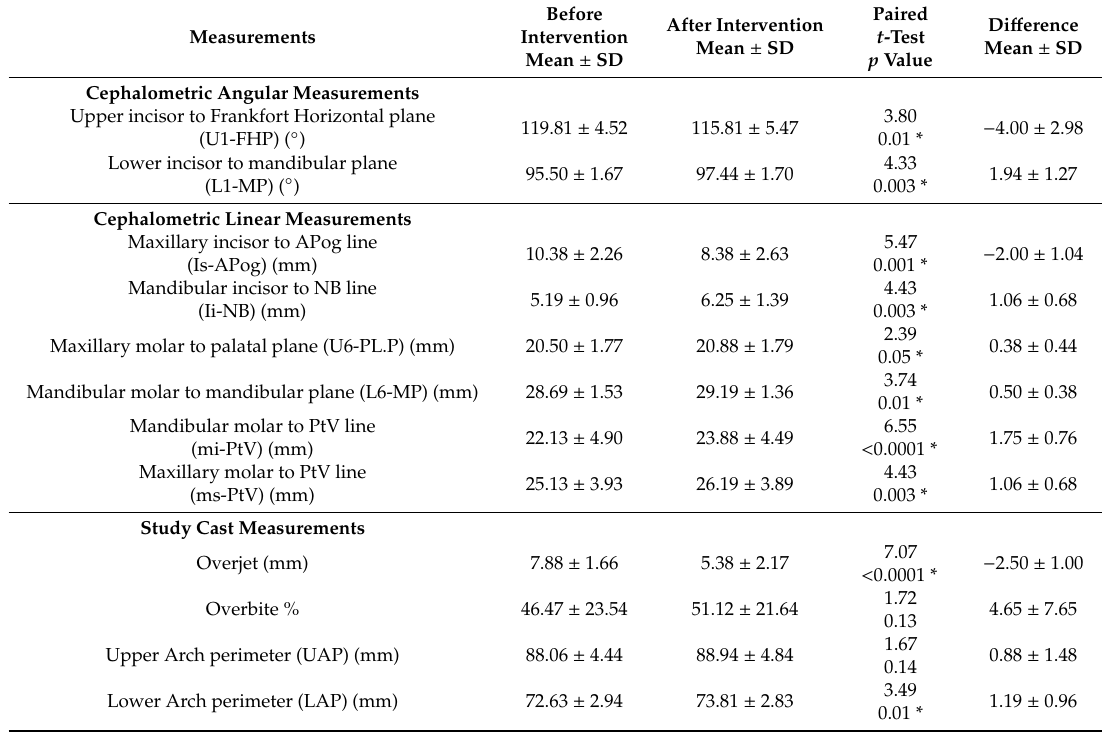
Table 2. Mean dentoalveolar measurements before and after intervention in Group I T4K.